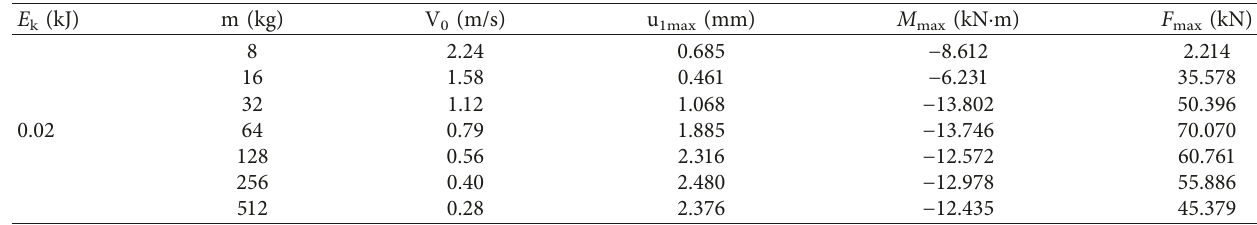
Figure 15: Relationship between impact energy and response parameters. (a) u1max-m; (b) Mmax-m; (c) Fmax-m; (d) u1max-Ek; (e) Mmax-Ek; (f) Fmax-Ek. Table 4: Numerical calculation results under each impact